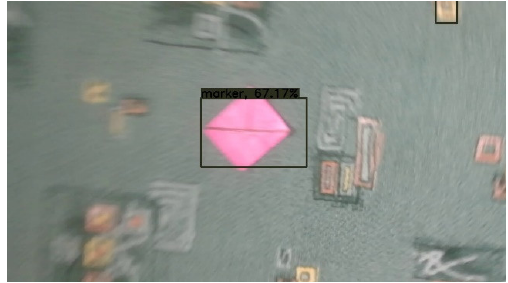
Figure 23. The only detected false positive case with 0.3 detection probability threshold; part of the carpet in the top right corner is falsely detected as a marker.